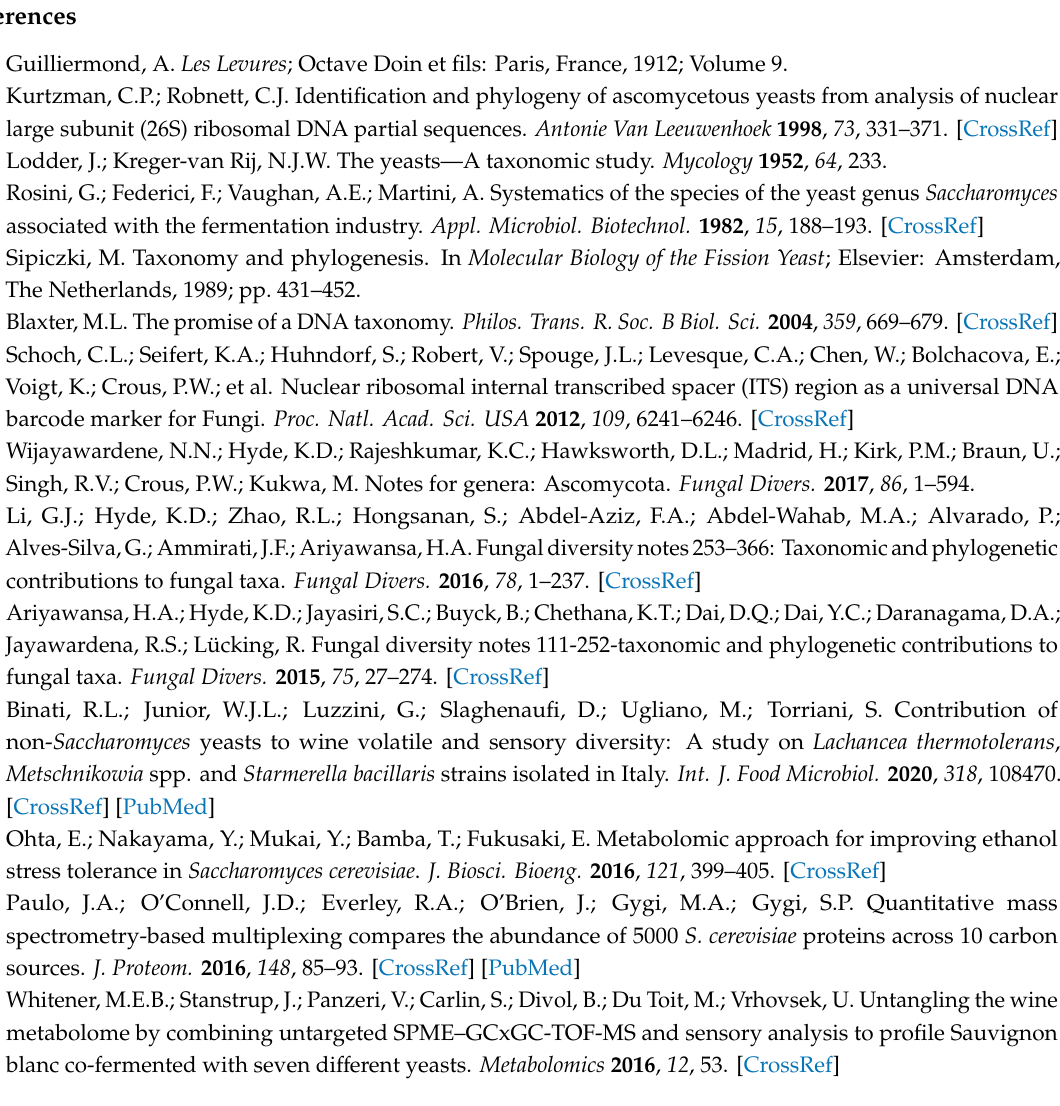
analysis. Table S10: Percentage of significative wavelengths in the correlations between markers and IR bioassay conditions. Table S11: Correlation values of genetic markers and four IR regions in control samples; Table S12: Correlation values of genetic markers and four IR regions in ethanol stressed